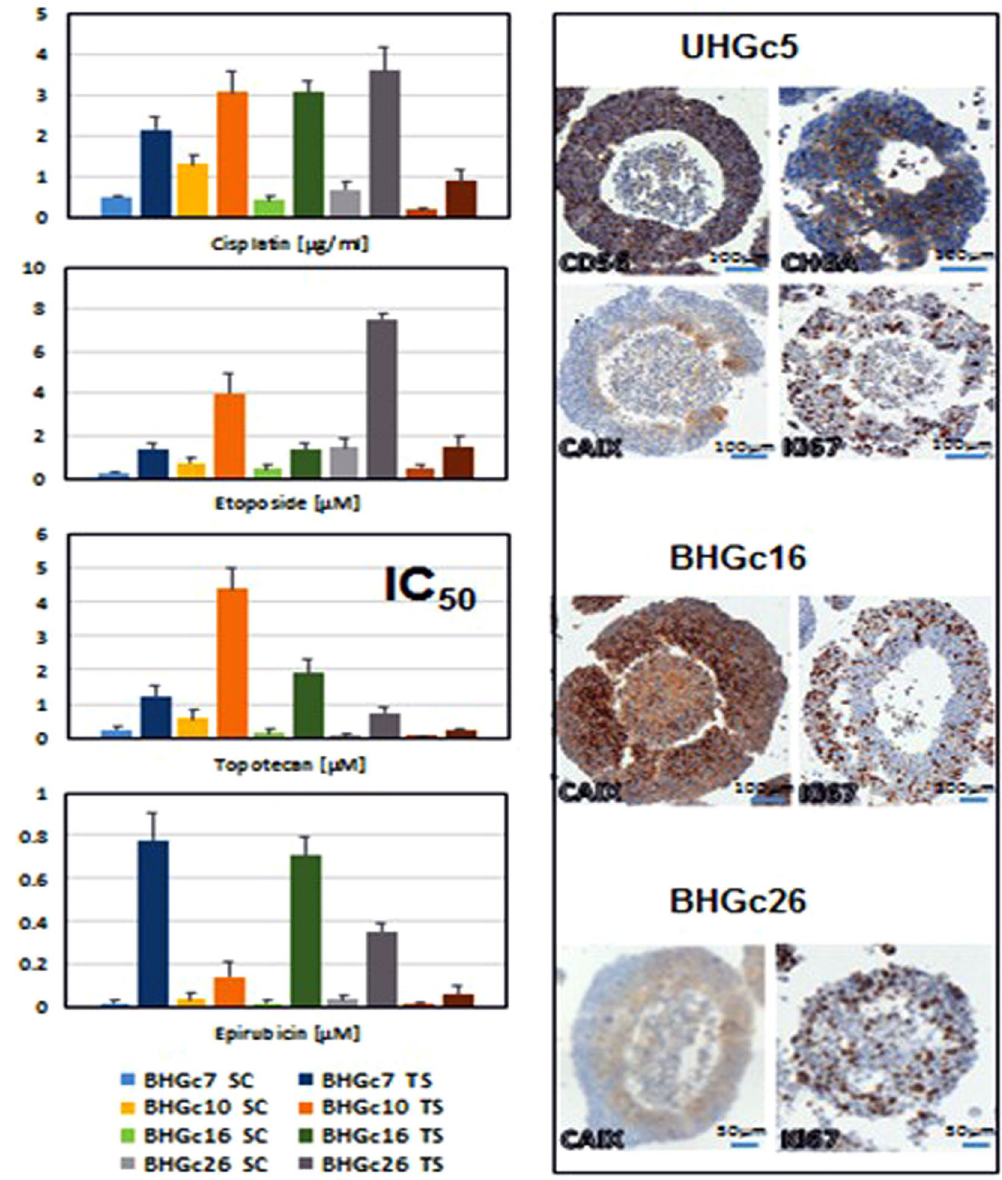
Figure 3. Chemosensitivity of the CTC SCLC lines (IC 50 , mean ± SD) and immunohistochemistry of sections of tumorospheres. All differences between single cells (SC) and tumorospheres (TS) are statistically significant. Immunohistochemical staining of sections of UHGc5, BHGc16 and BHGc26 CTCs was performed using antibodies directed to CD56, CHGA, CAIX and Ki67,